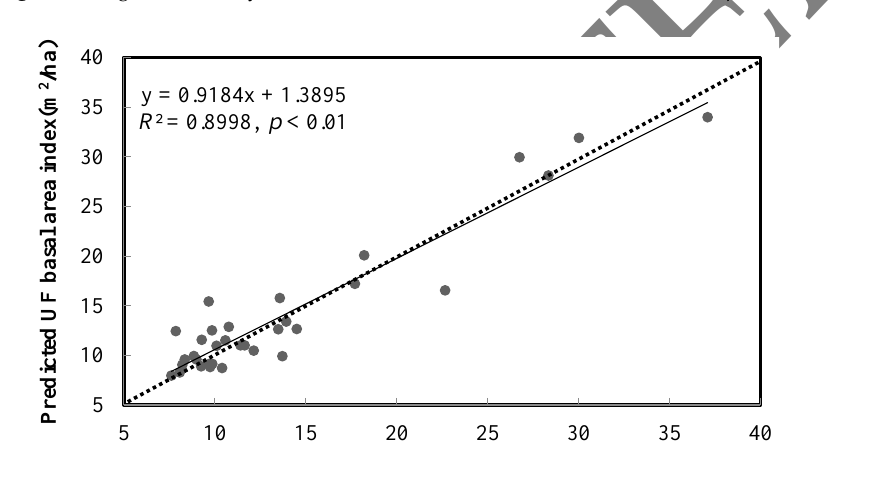
Figure 5. Regression analyses of NDVI with UF basal area index ( n = 129, p < 0.01).